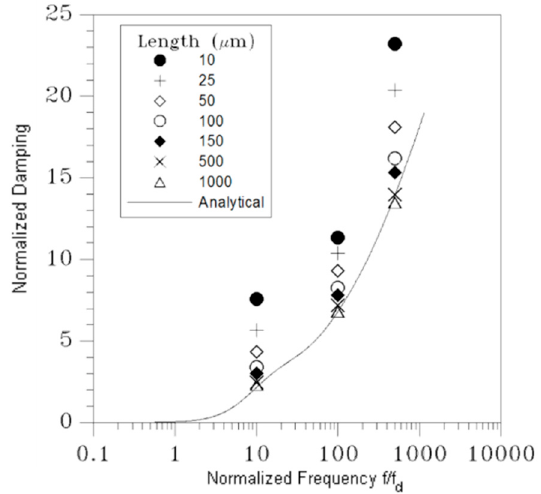
Figure 9. H = 3 µ m, disengaged solution, stick BCs: e ff ect of surface length on the normalized Figure 9. 𝐻 = 3 μm , disengaged solution, stick BCs: effect of surface length on the normalized damping damping value.